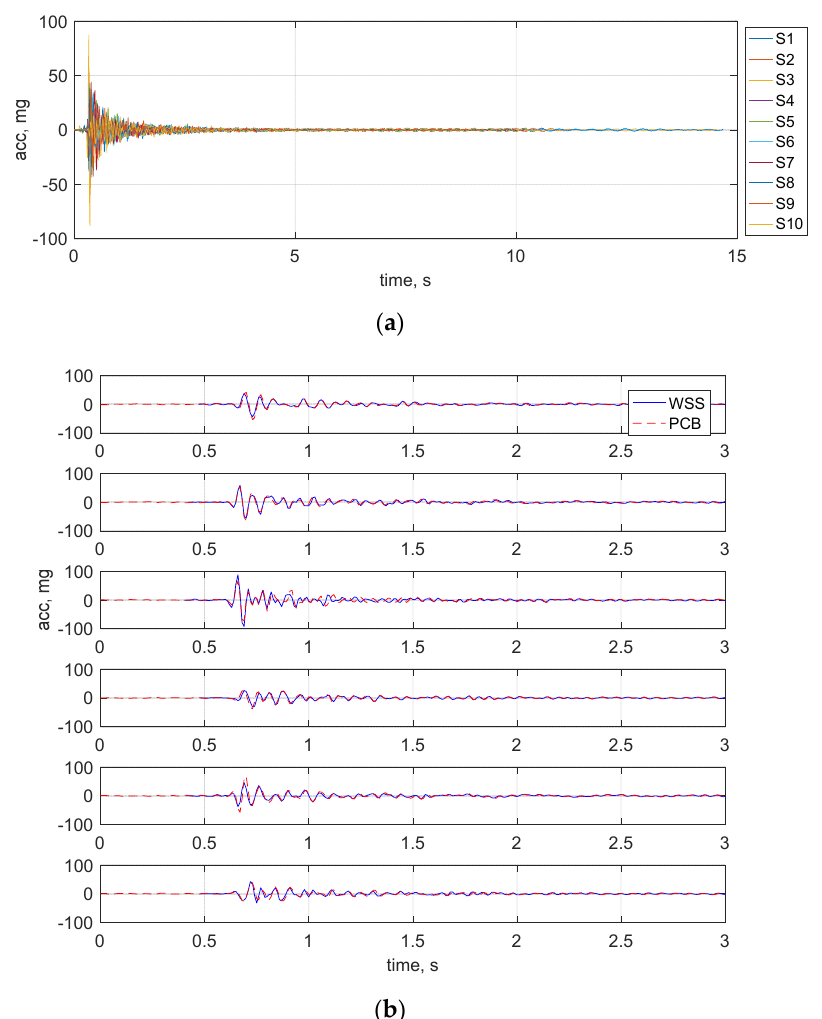
Figure 17. Impact response measurements: ( a ) vibration responses from WSS. ( b ) measurement comparison for node 1, 2, 3, 4, 8, 9. Table 4. Artificial neural network prediction results.